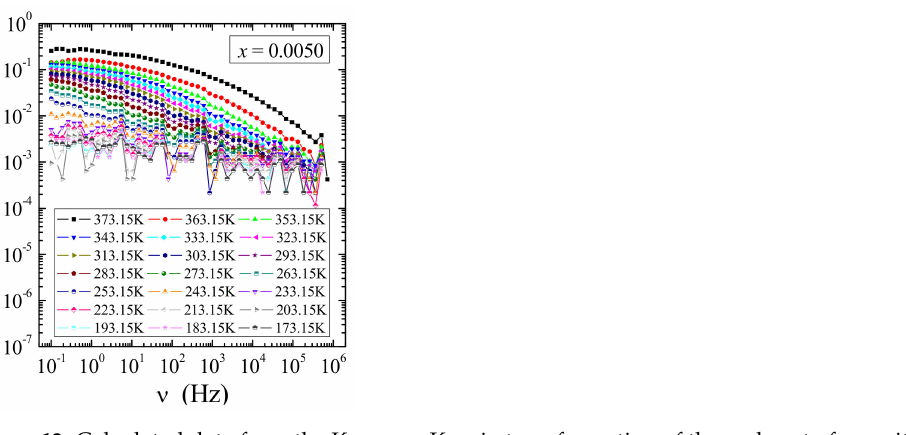
Figure 13. Calculated data from the Kramers–Kronig transformation of the real part of permittiity ( ε (cid:48) ) vs. frequency ν of CCGMWO solid solution for x = 0.0050 to the ε ” representation recorded in the temperature range of 173–373 K.